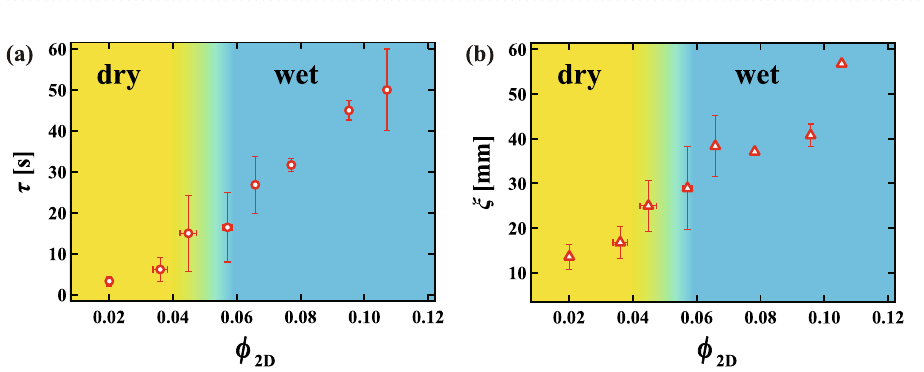
Figure 5. ( a ) Scattering plot of (cid:31) b and (cid:31) a , the mean of (cid:31) i averaged over the bubbles involved in a single collective rearrangement event before and after a rearrangement event, respectively. ( b ) Scattering plot of Z b and Z a , the mean contact number z i of bubbles involved in a collective rearrangement event before and after a rearrangement, respectively. Filled triangles in ( a ) and ( b ) show the mean (cid:31) i and z i over all bubbles in the foam, respectively. The black dashed lines represent the lines where (cid:31) b and (cid:31) a or Z b and Z a are equal. The color of each symbol represents the liquid fraction φ 2 D .